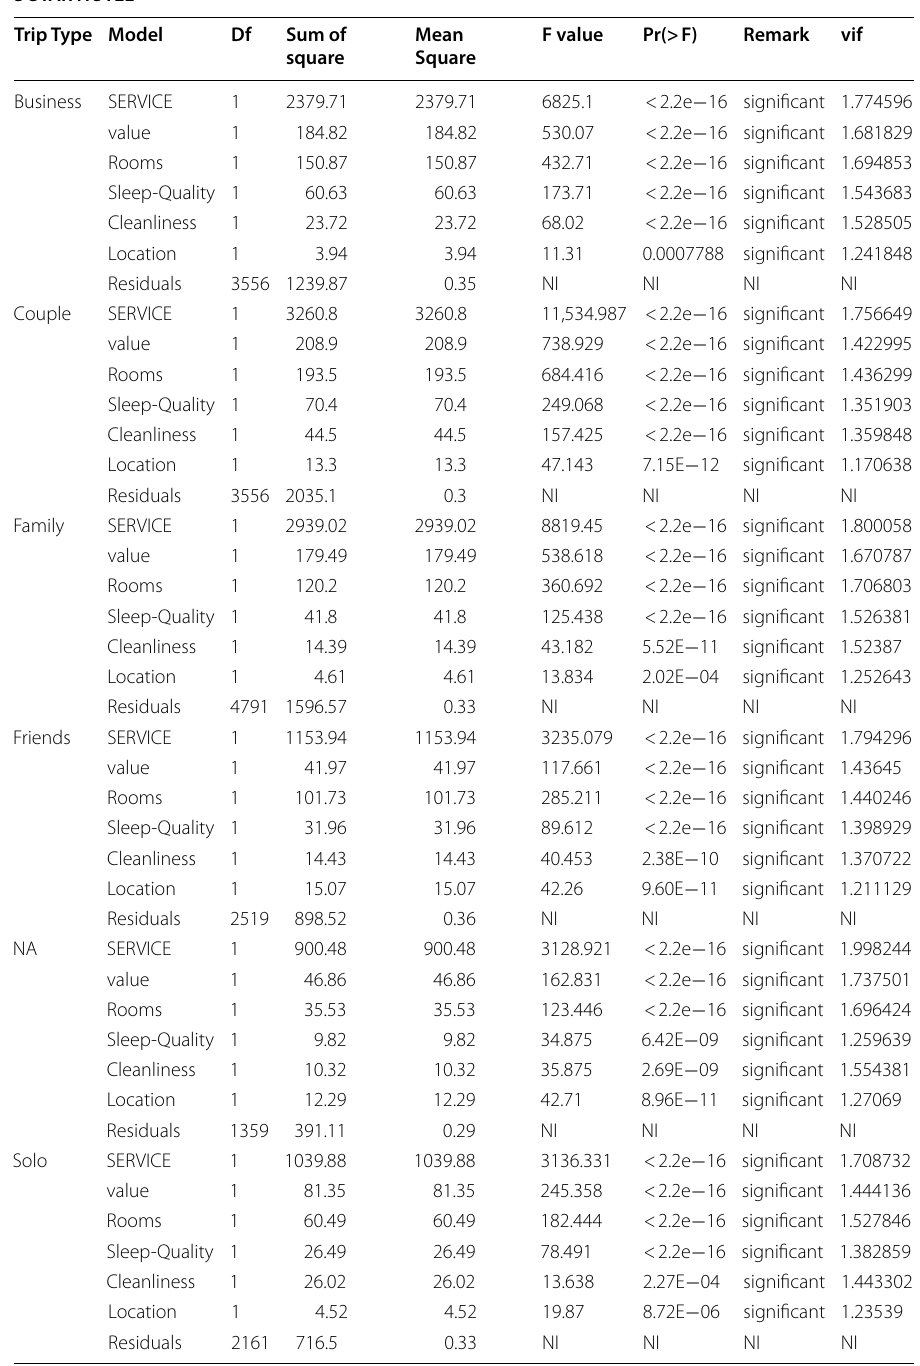
Table 11 Analysis of Variance of 3 star hotel class based on trip type 3 STAR